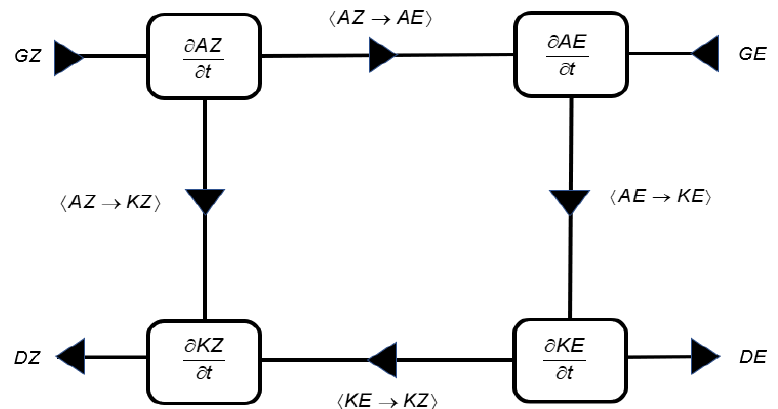
Figure 1. Lorenz energy cycle in the atmosphere. Zonal and eddy available potential energies are denoted by AZ and AE , respectively, while zonal and eddy kinetic energies are denoted by KZ and KE , respectively; rates of change of these energy forms are shown in the boxes as local derivatives with respect to time ( t ). For any two forms of energy, e.g., X and Y , the conversion of the former into the latter is shown as < X → Y >. The diabatic generation of AZ and AE is denoted by GZ and GE , respectively, and the dissipation of KZ and KE is denoted by DZ and DE , respectively.